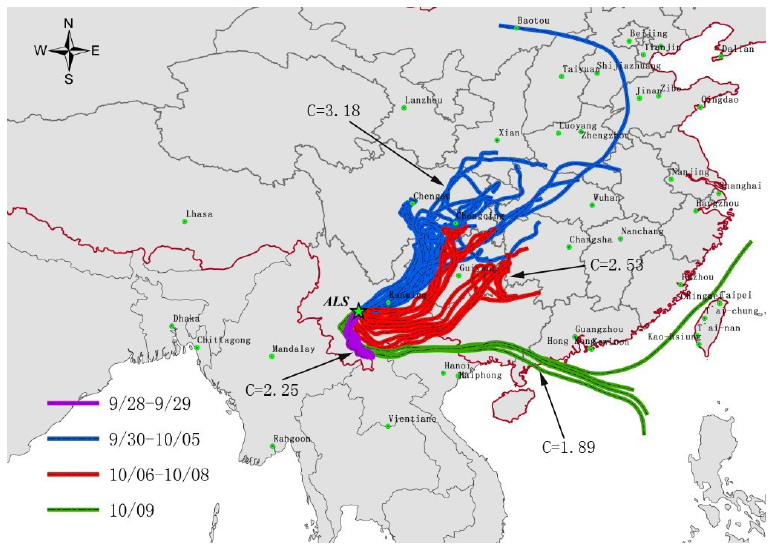
Figure 10. Backward trajectories of air masses and the variation of TGM concentrations because of the strengthening and incursion of air flow from EASM and the cold Siberian current from 28 September to 9 October 2011 during the non-ISM period (October–April). The TGM levels (C) were 2.25, 3.18 and 2.53ngm − 3 with the air masses from inland China. The TGM level was down to 1.89ngm − 3 with the air masses from the South China Sea, northern Vietnam and Laos.